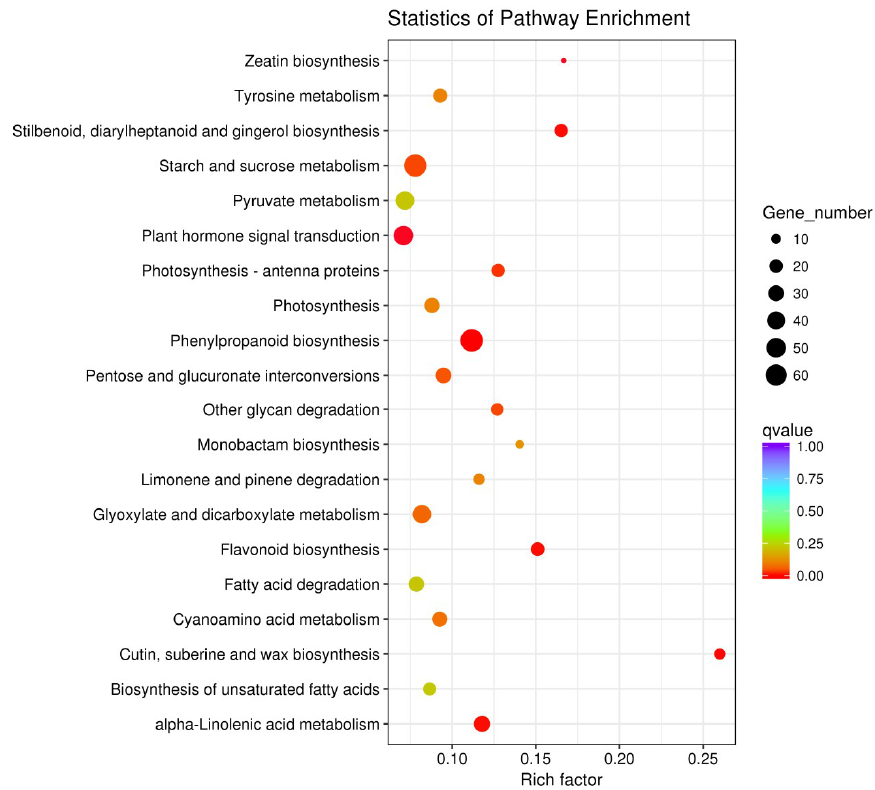
Figure 5. KEGG enrichments of the annotated differentially expressed genes (DEGs). The left Y -axis indicates the KEGG pathway. The X -axis indicates the rich factor (the number of genes enriched in this pathway compared to the number of genes on this pathway.). High q values are shown in blue, and low q values are shown in red.